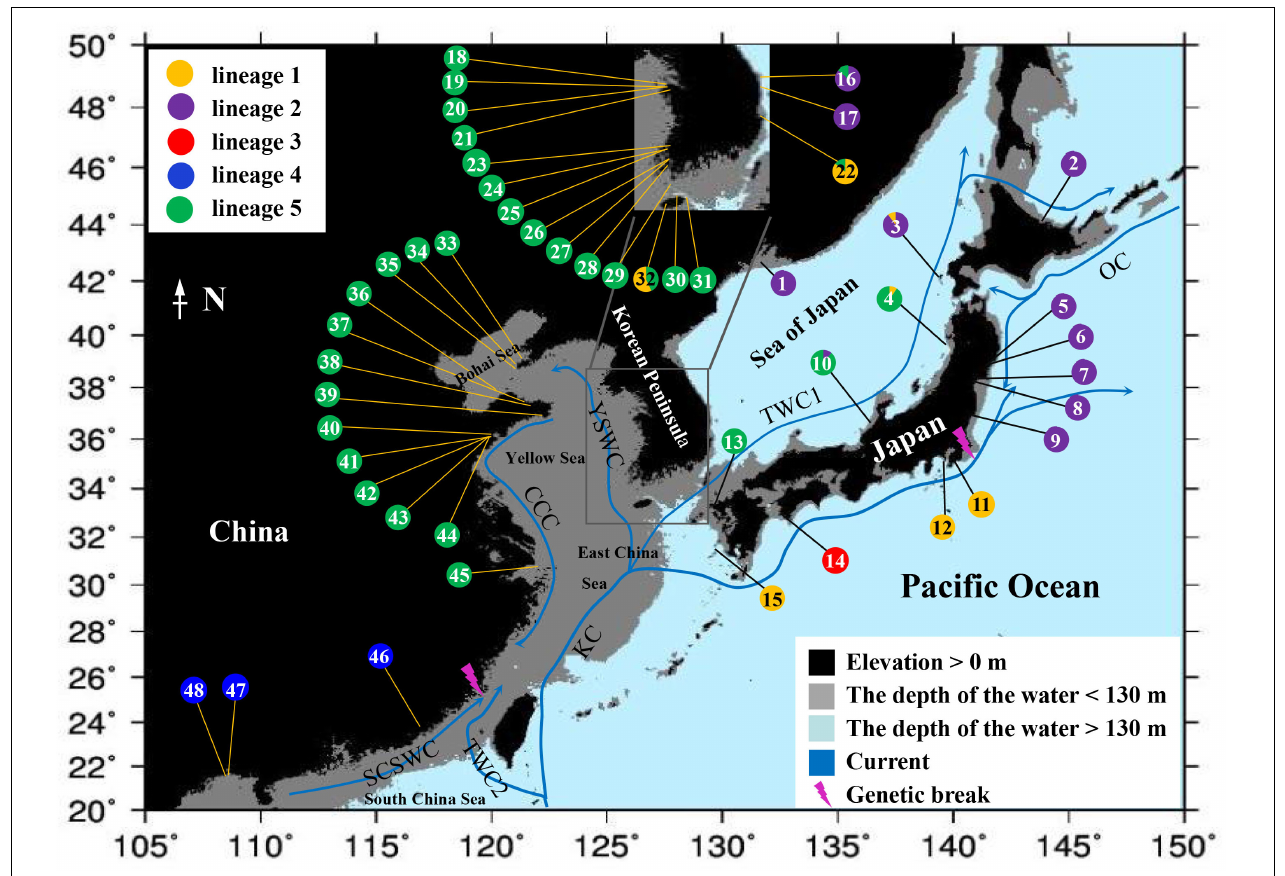
FIGURE 1 | Geographical distribution of mtDNA cox 1 haplotypes in the northwest Pacific. Numbers in pie charts correspond to sampling localities in Supplementary Table S1 . Colors corresponds to the lineages indicated in the phylogenetic tree ( Figure 2 ) and haplotype network ( Figure 3 ). The black areas represent the elevation > 0 m, the gray areas represent the depth of water < 130 m, and the light blue areas represent the depth of water > 130 m (sea levels during the last glacial maximum). KC, Kuroshio Current; TWC1, Tsushima Warm Current; YSWC, Yellow Sea Warm Current; CCC, China Coastal Current; TWC2, Taiwan Warm Current; SCSWC, South China Sea Warm Current; OC, Oyashio